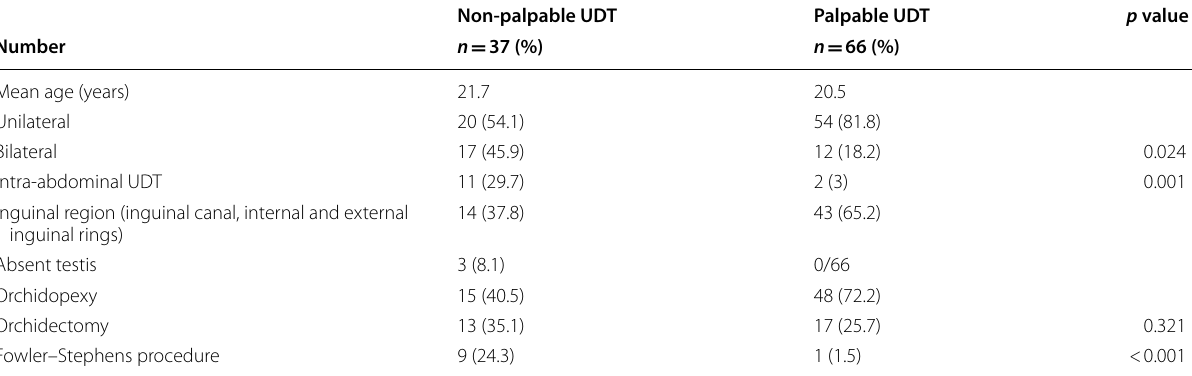
Table 2 Comparison between non-palpable and palpable undescended testes, clinical findings and management